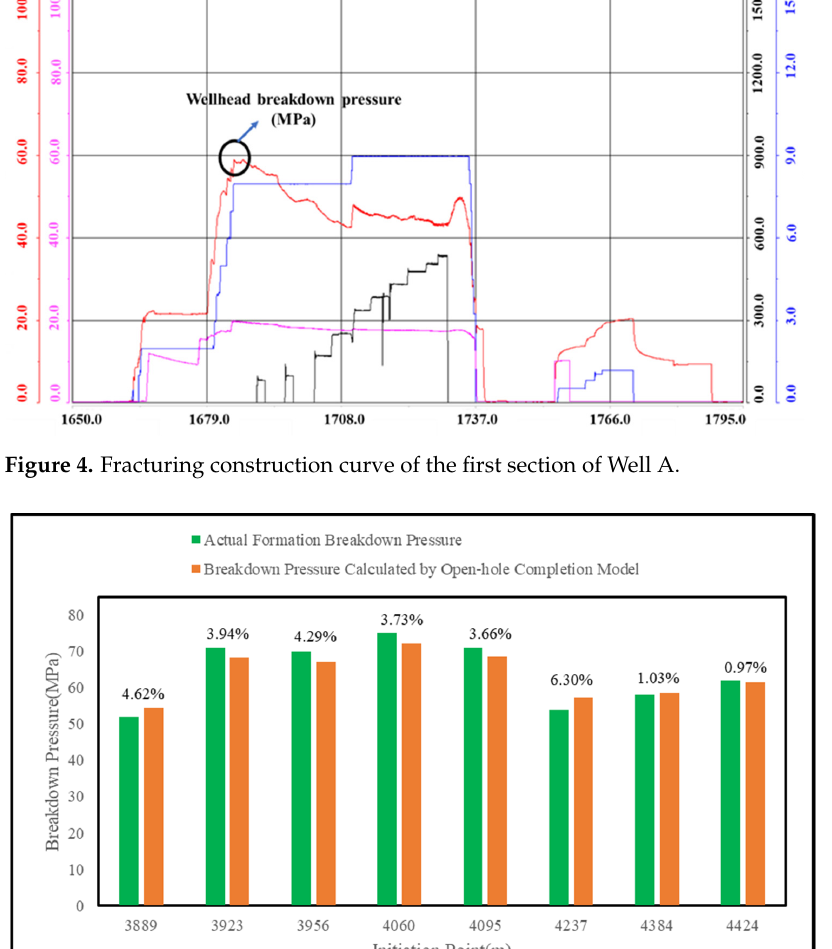
Figure 4. Fracturing construction curve of the first section of Well A. Table 2. Basic data.